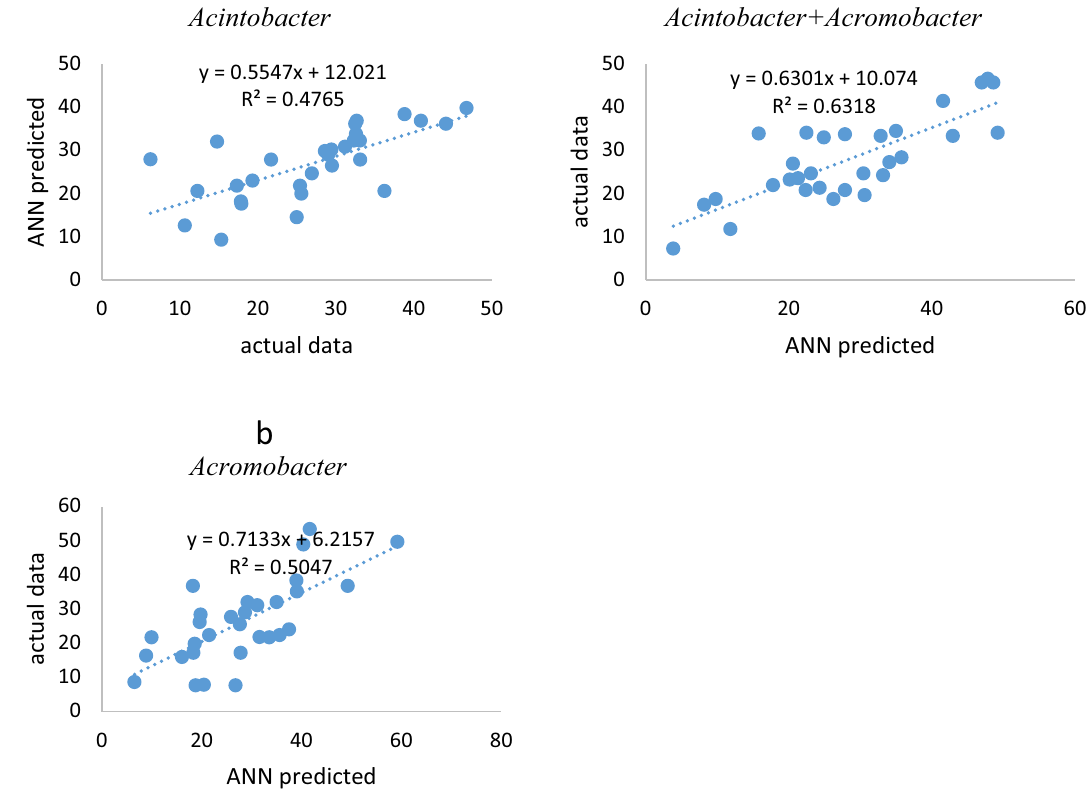
Figure 4. The correlation coefficient of ANN predicted vs actual data. ( a ) Acintobacter , ( b ) Acromobacter and ( c ) consortium of Acintobacter and Acromobacter .